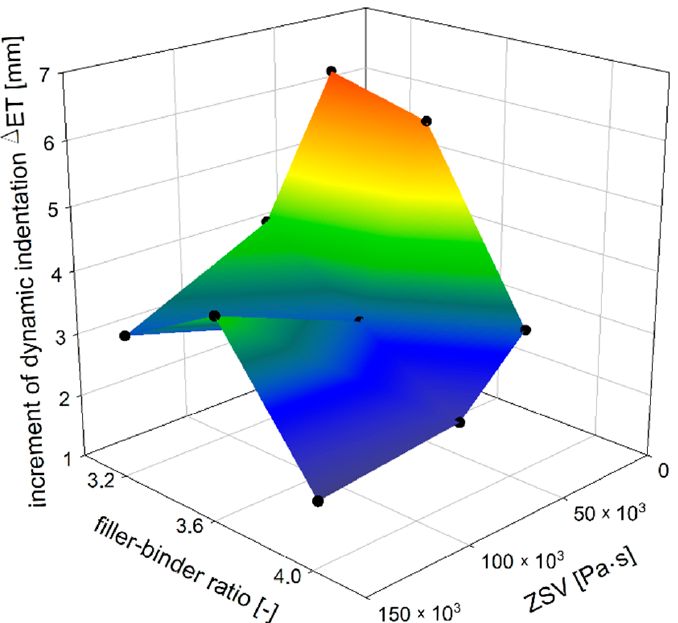
Figure 13. The dependence of increment of MA dynamic indentation on ZSV of TLA-modified binder and filler–binder ratio.